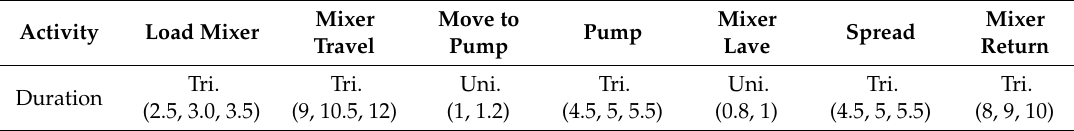
Table 2. Activity durations (min) in terms of probability